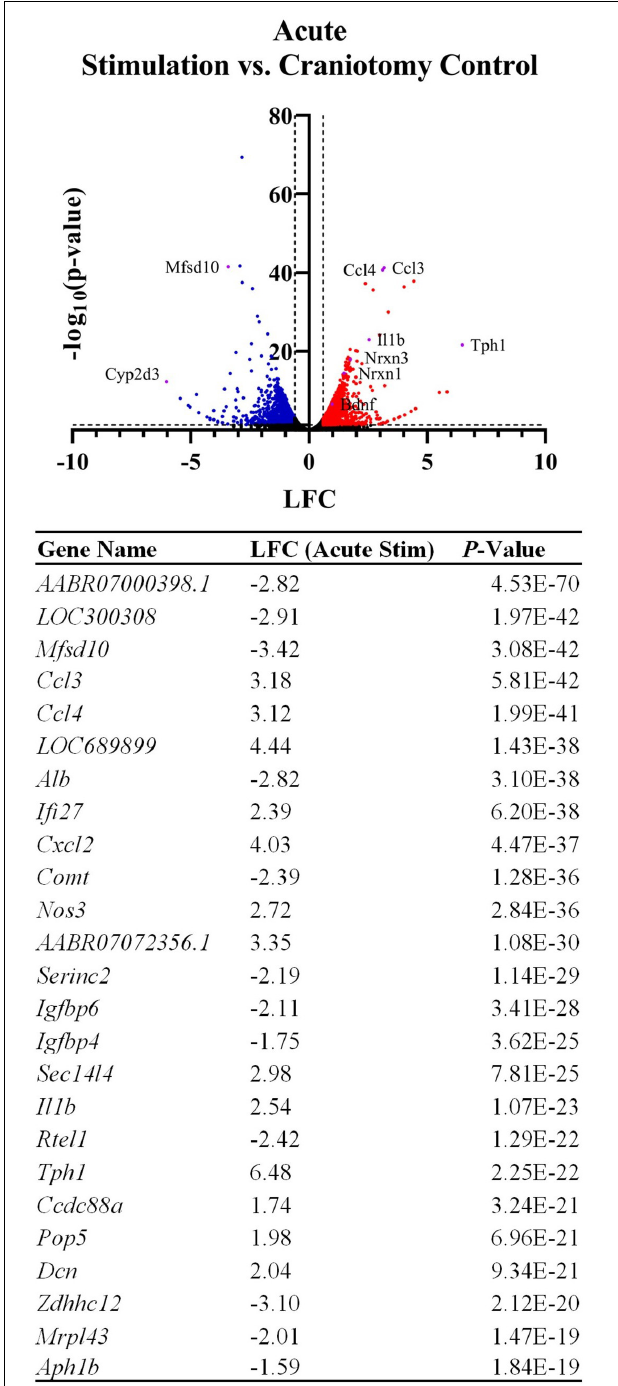
FIGURE 2 | Device implantation and stimulation influences the expression of thousands of genes in comparison to a sham procedure (craniotomy only). The volcano plot and table show differentially expressed genes between the craniotomy control and the two acute stimulation samples, with genes related to inflammatory cytokines and related signaling cascades upregulated by the device insertion and stimulation. LFCs are reported as the change in gene expression in the stimulated samples compared to the control samples. The table shows the top 25 most significant DE